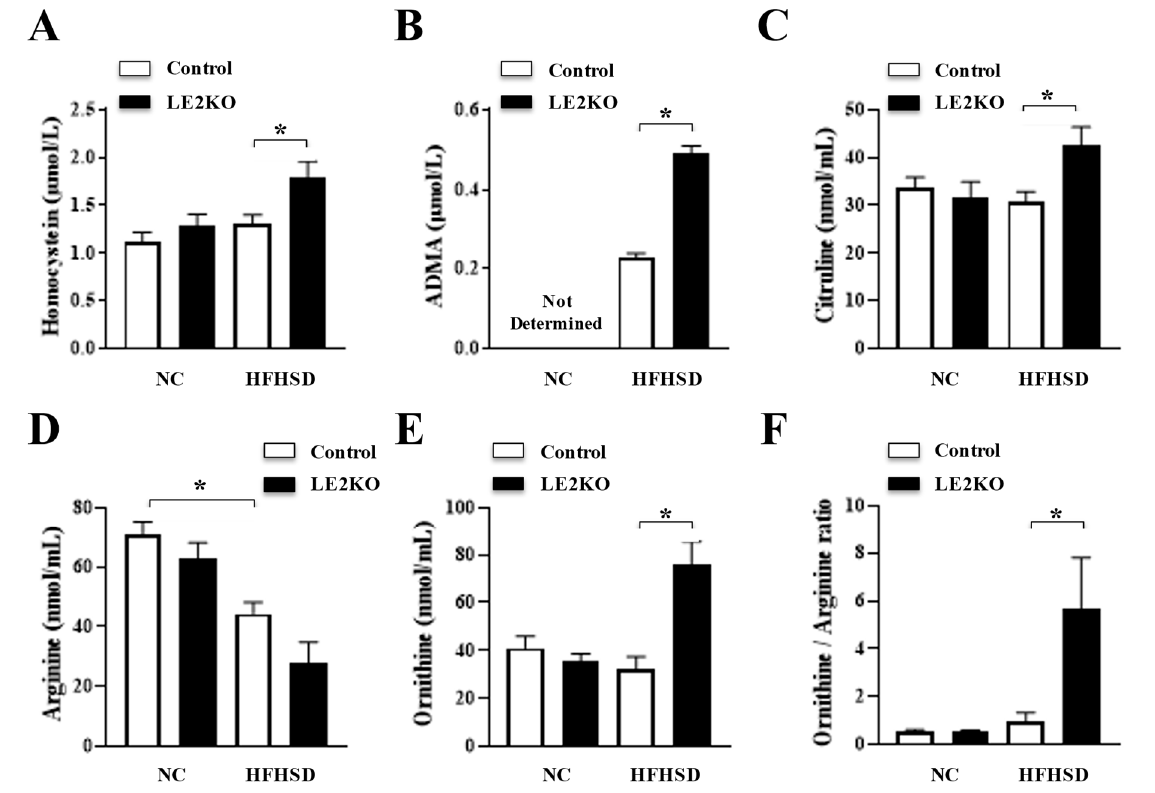
Figure 5. Serum Amino Acid Profile. ( A ) Homocystein, ( B ) asymmetric dimethylarginine (ADMA), ( C ) Citrulin levels were higher in HFHSD-LE2KO than HFHSD-Control. ( D ) Arginine level was lower in HFHSD-Control than NC-Control, and ( E ) Ornithine and ( F ) Ornithine/Arginine ratio were higher in HFHSD-LE2KO than HFHSD-Control. ( n = 8 for each group). Data are mean ± SEM and median (interquartile range). (nmol/mL) p values were determined by ANOVA (* p < 0.05). n = 8 for each group.